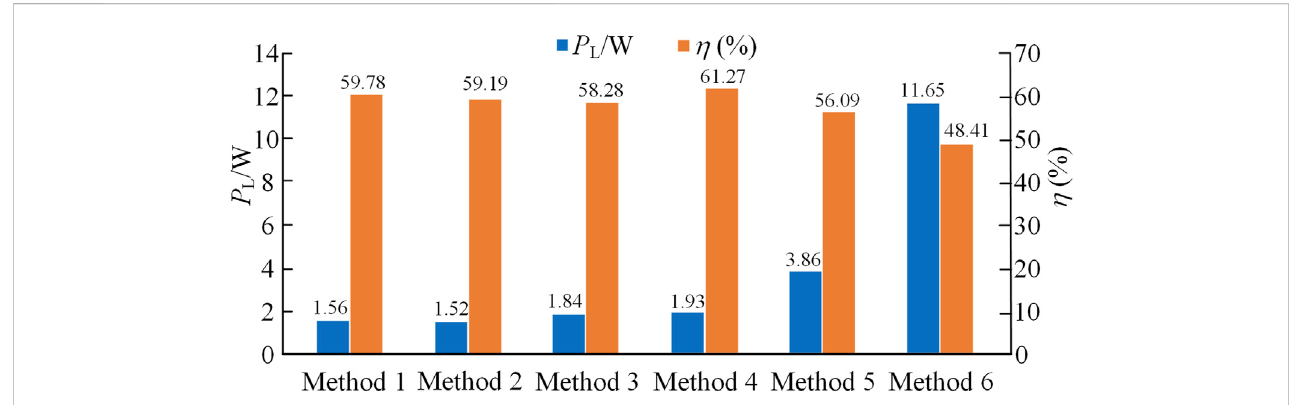
FIGURE 8 System performance under different